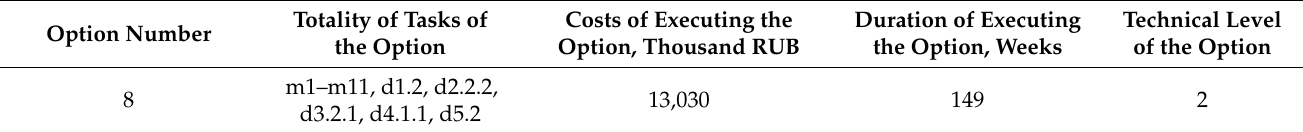
Table 9. The specification of the chosen project